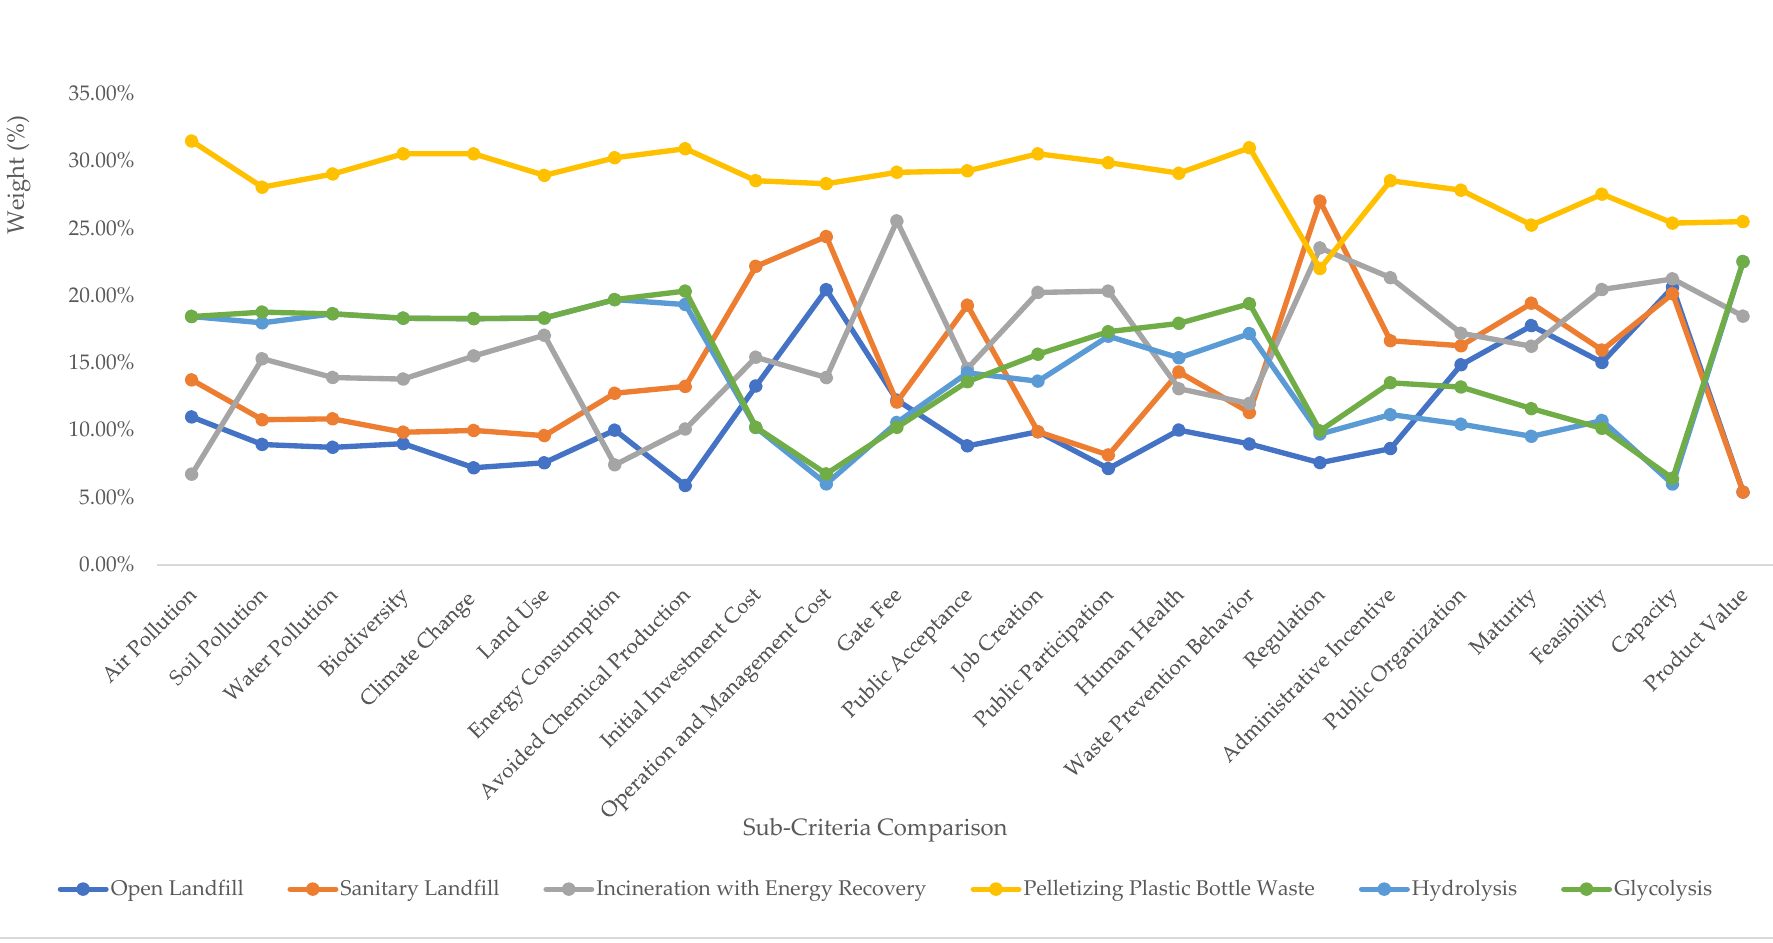
Figure 7. Indonesian experts’ sub-criteria judgment results for the alternatives (%).